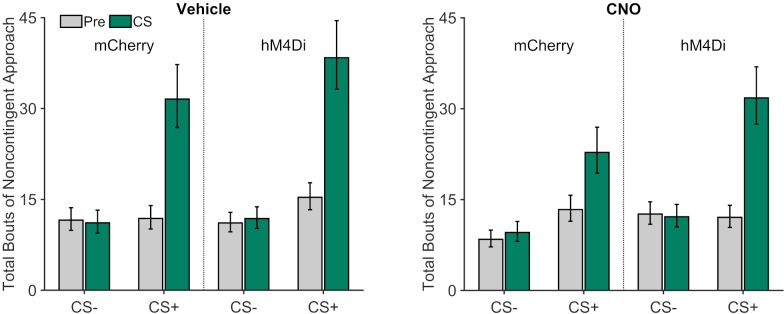
Noncontingent (press-independent) food-cup approaches during PIT testing by rats expressing the inhibitory DREADD hM4Di or mCherry following vehicle or CNO (5 mg/kg) treatment in Experiment 2.Data from pre-CS (gray) and CS (green) periods are plotted separately. Error bars represent ±1 standard error of the estimated marginal means from the corresponding fitted generalized linear mixed-effects model. This behavior was selectively increased by the CS+ relative to the CS- (CS Period * CS Type interaction, t(240) = 11.72, p<0.001). CNO produced a nonspecific (hM4Di-independent) suppression in this approach response (Drug effect, t(240) = −1.99, p=0.047), which was more pronounced for the mCherry group (Group * Drug * CS Type * CS Period interaction, t(240) = 2.73, p=0.0067).